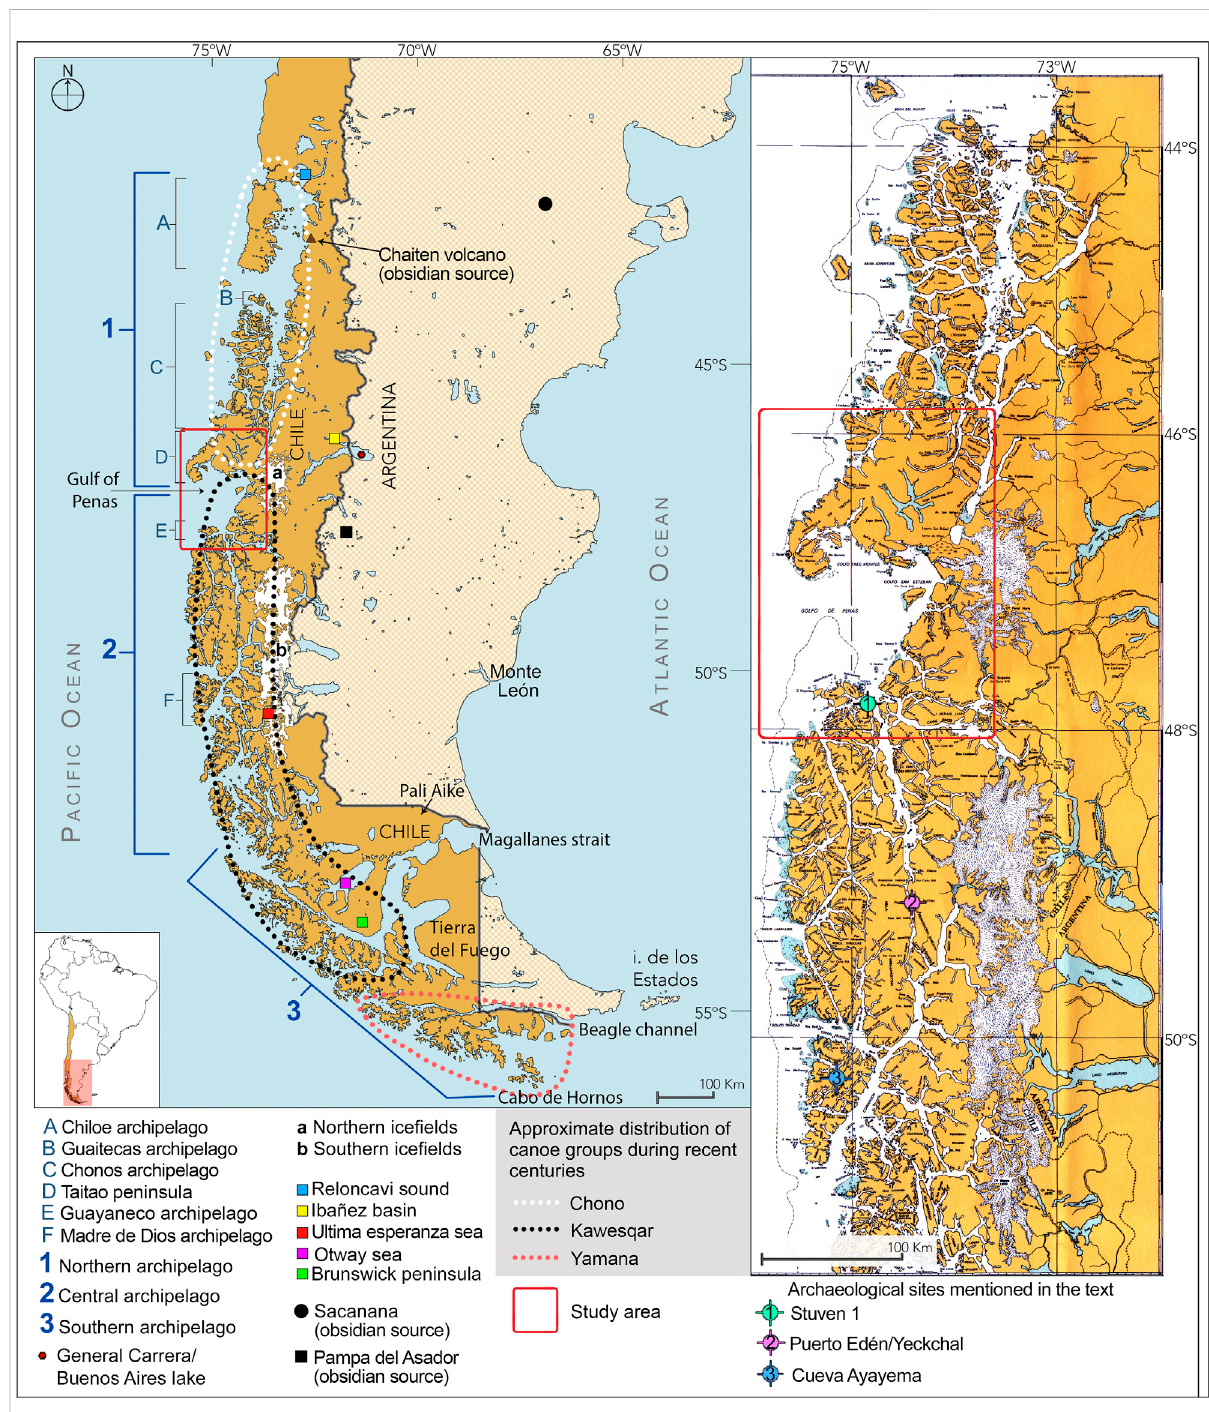
FIGURE 1 West Patagonia. Principal geographical features and archaeological sites mentioned in the